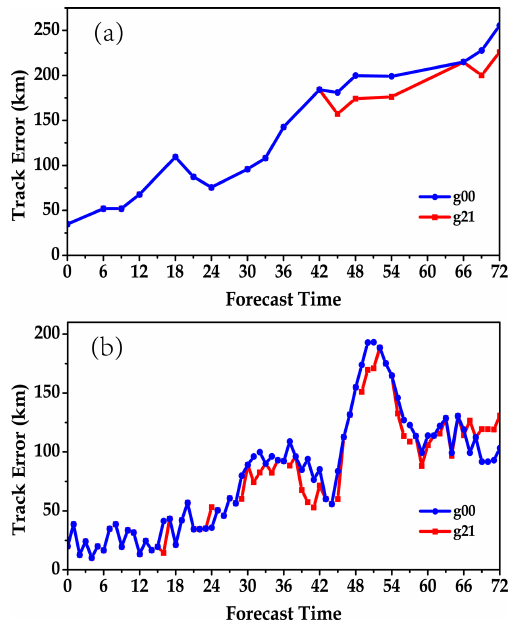
Figure 11. Time evolution of the forecasted track errors of G00 and G21 experiments for the typhoons Lekima and Krosa during the forecast period of 72h (values are given in